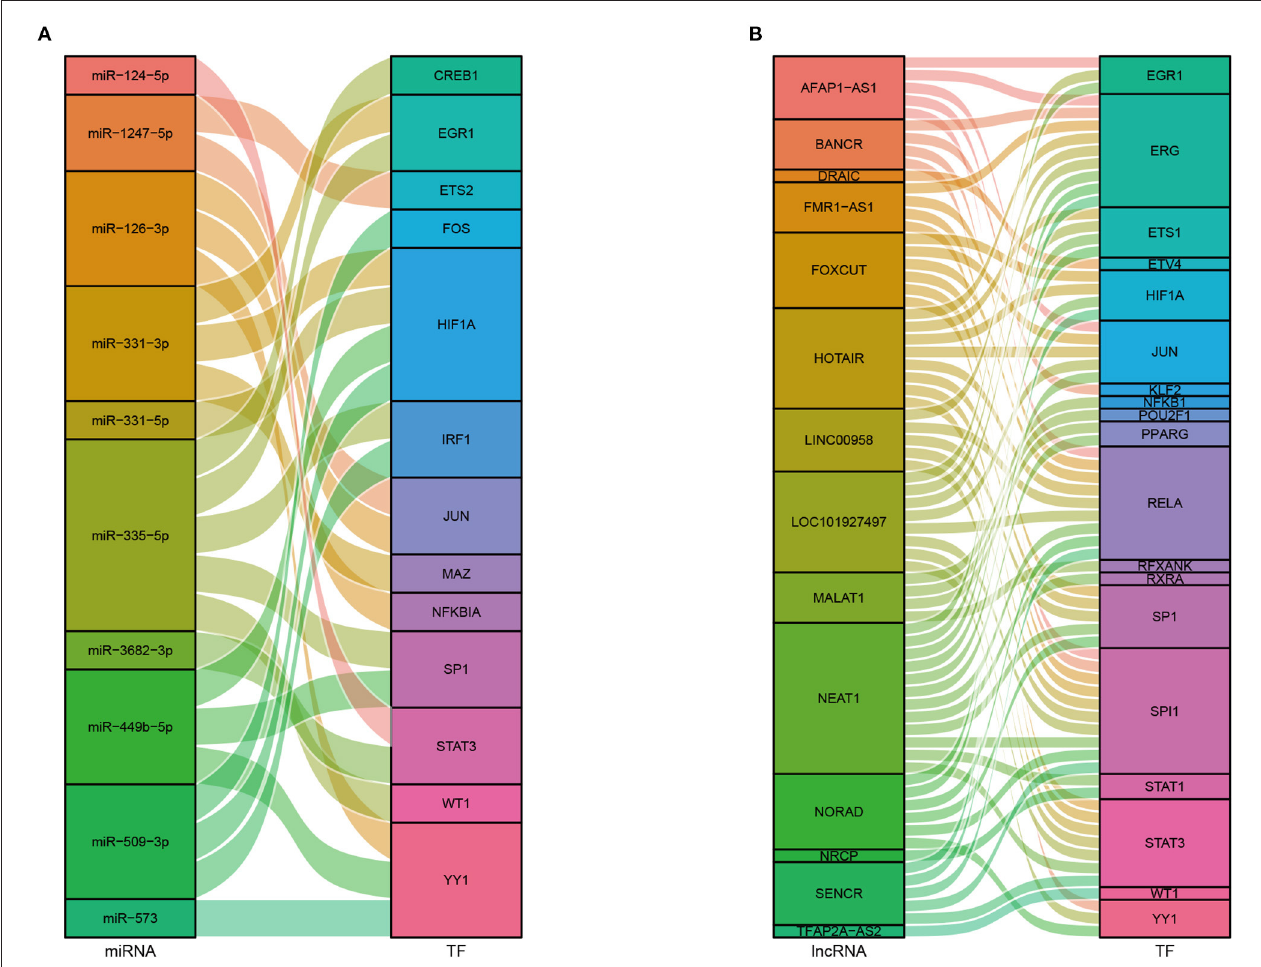
FIGURE 7 | Sankey diagrams of the interactions between ncRNAs and TFs. (A) Interactions between miRNAs and TFs. (B) Interactions between lncRNAs and TFs.